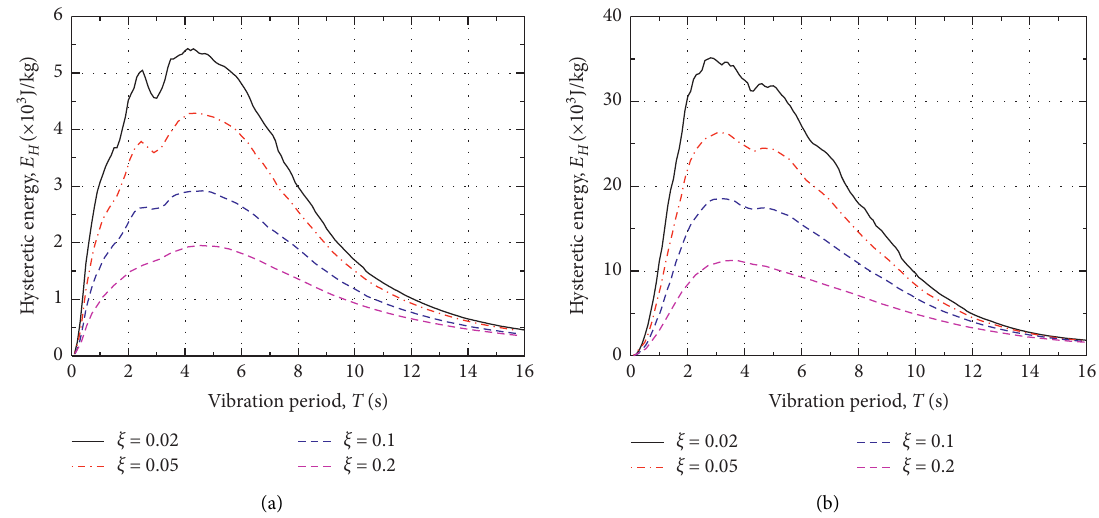
Figure 15: Hysteretic energy spectra affected by damping ratio. (a) Near-fault pulse-like ground motions. (b) Far-field harmonic ground